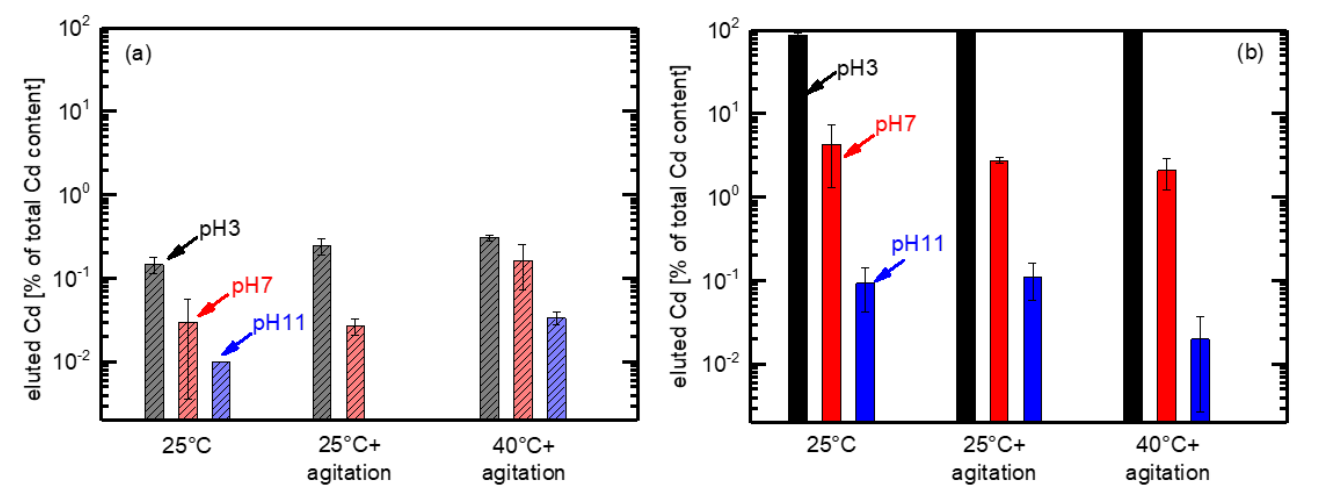
Figure 11. Dramatic difference between the leaching data after one day and more than a year of Cd out of CdTe module pieces. ( a ) Amount of eluted Cd from CdTe module pieces after t = 1 day in solutions of pH 3, 7, and 11 and different leaching conditions: with/without agitation and increased temperature T IT = 40 ◦ C plus agitation. For all conditions, after one day, the Cd concentration ranges below 1%. ( b ) Amount of eluted Cd from CdTe module pieces after t = 416 days. For pH 3, almost 100% of the Cd is leached out. For pH 7, still several percent are leached out. This finding raises the question of the meaningfulness of judging the toxicity of CdTe containing modules with tests that are carried out for one day